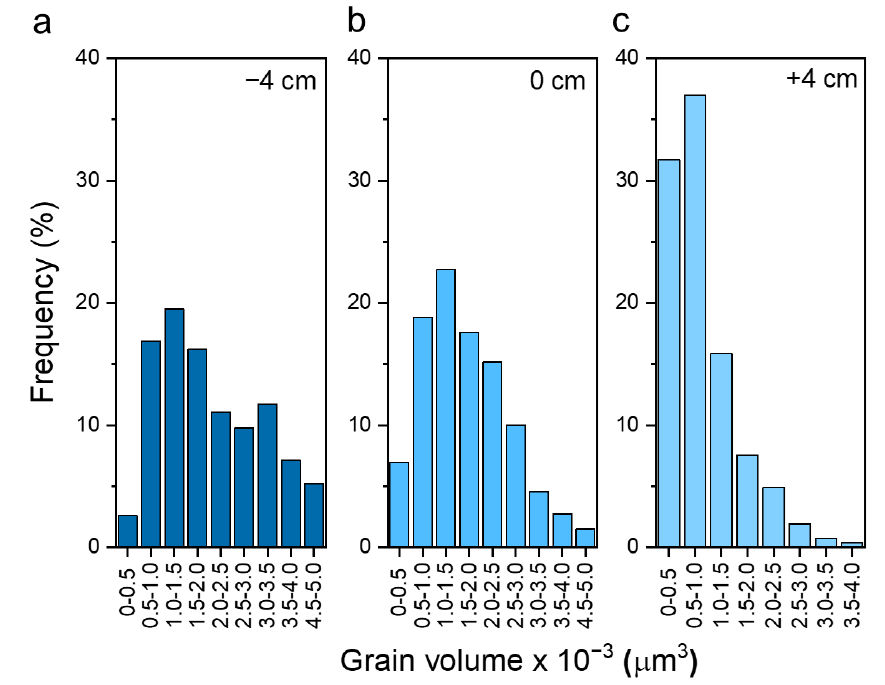
Figure 2. Grain size distribution in Sb 2 Se 3 seed layers deposited at ( a ) −4 cm, ( b ) 0 cm, and ( c ) +4 cm distances between zone edge and sample. Grain volume was calculated by multiplying seed layer thickness with measured grain surface area estimated from SEM image.